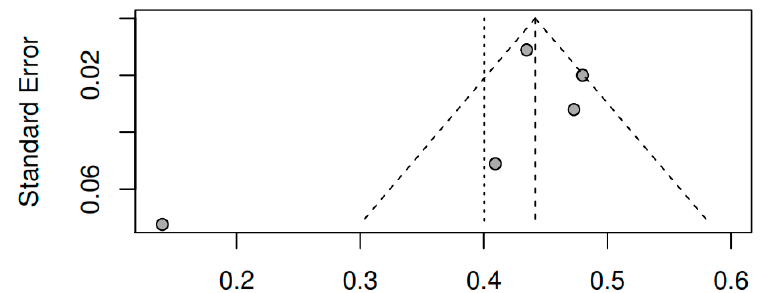
Figure 10. Funnel plot of the positive symptoms variable (pretest–posttest).